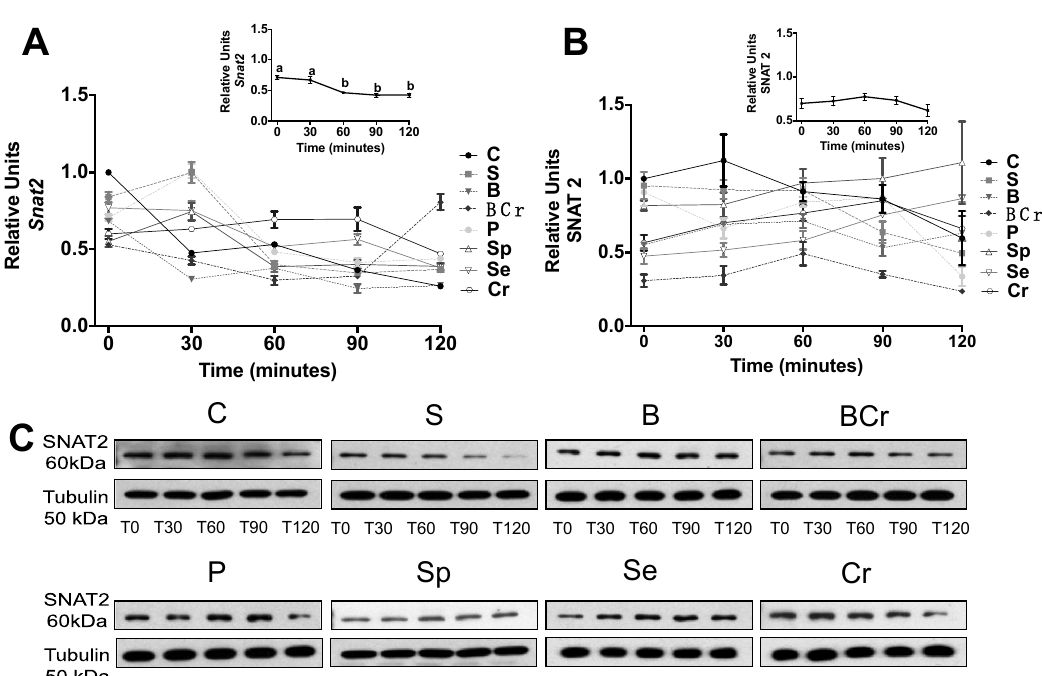
Figure 3. mRNA gene expression and Western blot analysis of SNAT2 in liver of healthy rats fed different types of dietary protein: ( A ) Snat2 mRNA abundance; ( B ) protein abundance of Snat2 ; and ( C ) representative immunoblot of SNAT2. Values are means ± SEM, n = 3. Different letter superscript indicates significant differences among different times of feeding, p < 0.05, a > b > c.